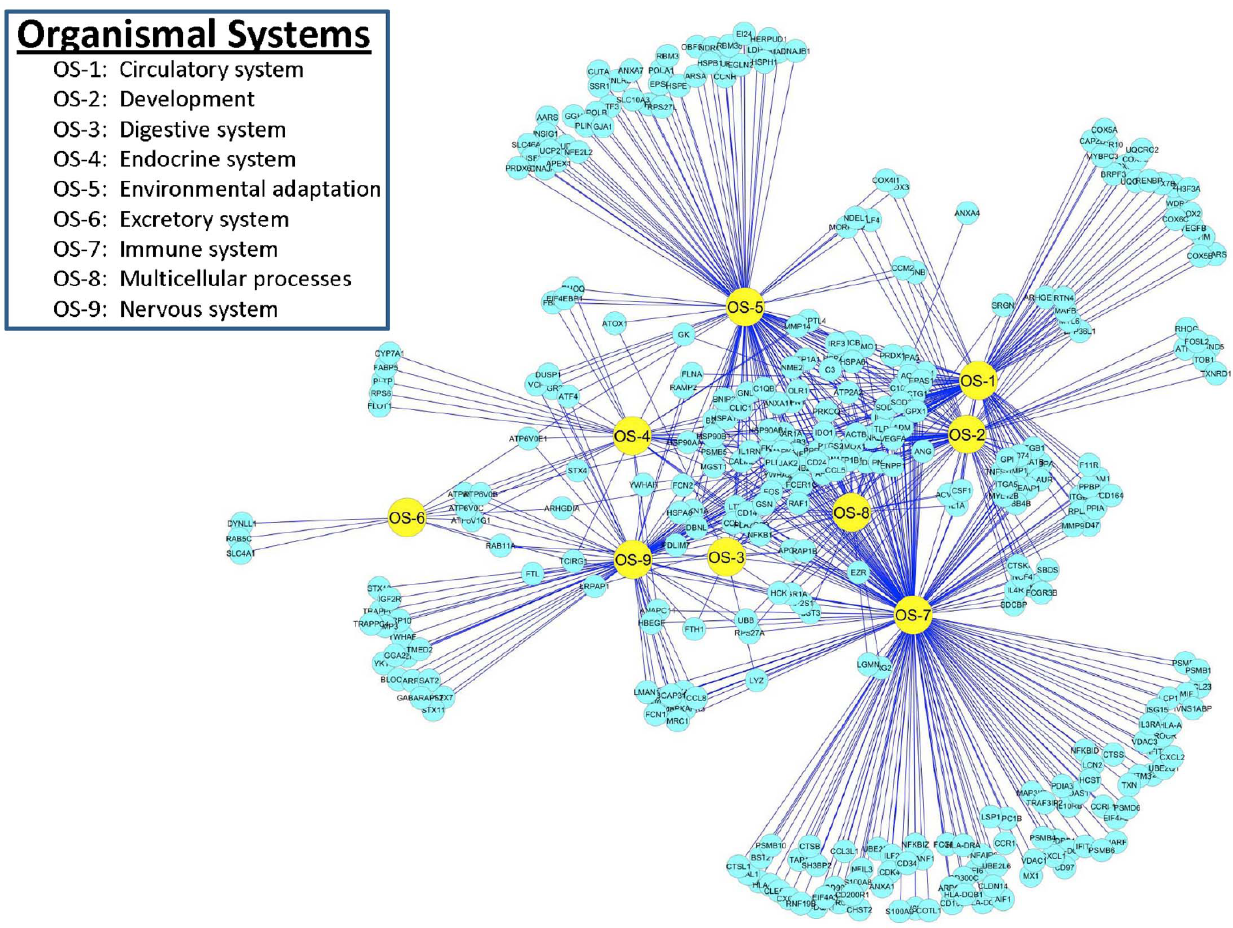
Figure 10. DE gene distributions and interactions among functional categories associated with Organismal Systems in PAMs infected with PRRSV.